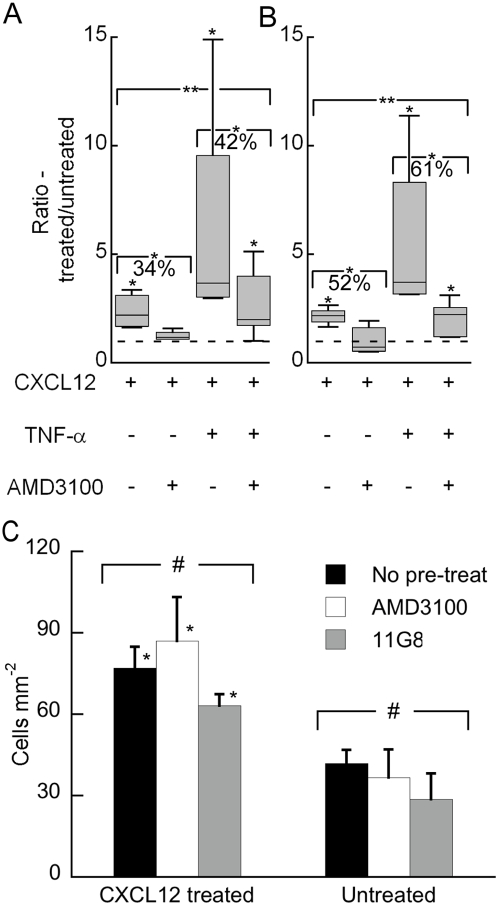
Endothelial-CXCR4 dependent adhesion of cancer cells.(A) Adhesion selectivity of 231-control cancer cells towards regions of the endothelium treated with different combinations of CXCL12, TNF-α and the CXCR4 inhibitor AMD3100 for 5 hours under 0.50 dyn cm−2 flow conditions (*). The levels of adhesion onto the differently treated regions were statistically different (**). AMD3100 in the presence of CXCL12 decreased adhesion by 34% relative to the CXCL12 only condition (*). AMD3100 in the presence of CXCL12 and TNF-α decreased adhesion 42% relative to CXCL12+TNF-α (*). The dotted line represents a ratio of 1 or no adhesion selectivity. (B) Same as (A) except the experiments were performed under 2.50 dyn cm−2 flow conditions. n = 4–6 for each condition. (C) Adhesion of 231-control cancer cells is not affected by pre-treatment with chemokine receptor inhibitors. 231-control cells were pre-treated for 5 h with either an inhibitor for CXCR4 (AMD3100) or an anti-CXCR7 antibody (11G8) and compared to no pre-treatment. The level of adhesion was statistically the same for all three conditions onto either CXCL12 treated (5 h) or untreated endothelium (#, p>0.34). For all 231-control cell pre-treatment conditions, the level of adhesion was greater onto CXCL12 treated versus untreated endothelium (*). n = 5–6 for each condition.